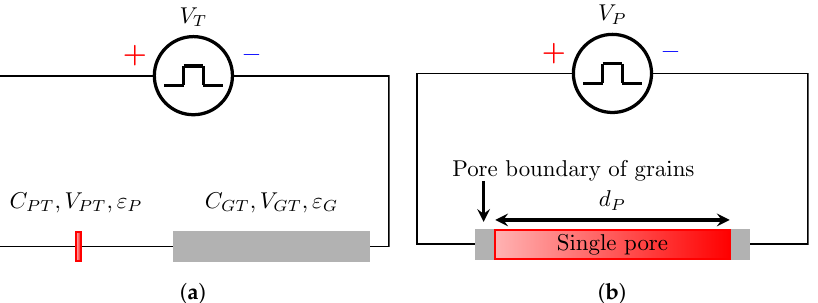
Figure 3. ( a ) The equivalent circuit for the single rock pore unit (red capacitor) and the single rock grain unit (gray capacitor), which are exposed to the pulse voltage drop, V T , as demonstrated in Figure 1b. ( b ) Sketch of the one-dimensional plasma simulation domain (used in ZAPDOS Lindsay et al. [53]), which is a single rock